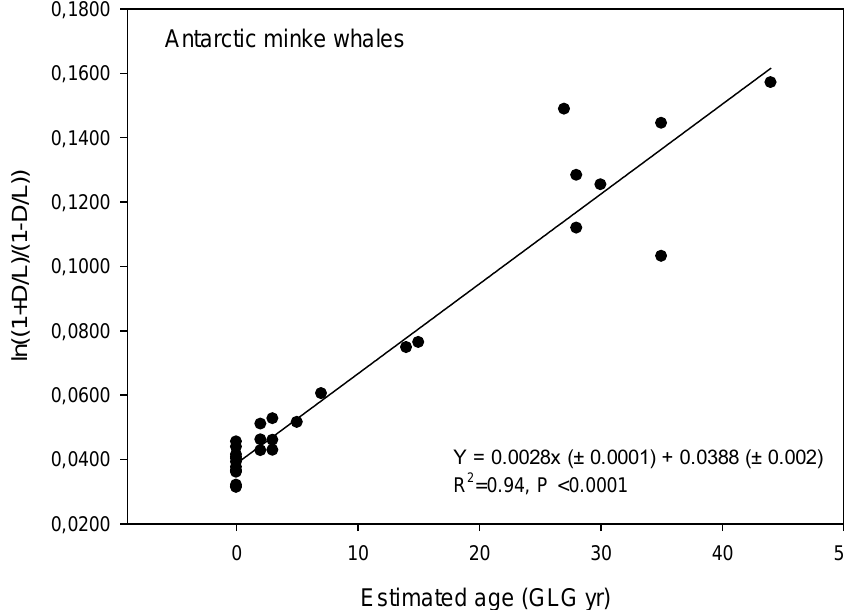
Fig. 1. Regression line of D/L ratios against GLG readings from 17 Antarctic minke whales and 13 features (0 yr.). The slope of the regression line corresponds to twice the racemization rate (2 k ) and the intercept Asp corresponds to twice the (D/L 0